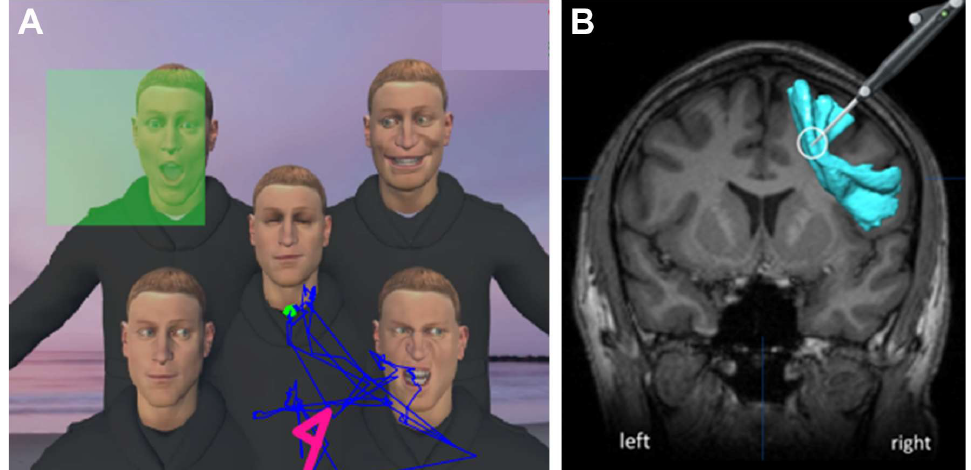
Figure 5. Resection of a malignant glioma in the frontal lobe. ( A ) VR-TANGO test during the DES. The patient was unable to detect the communicative cues, namely, eye contact (green square at the top left). His gaze remained fixed on the first face encountered. ( B ) Coronal neuronavigation showing the location of the DES electrode (white circle) in contact with the FAT (blue). (DES, direct electrical stimulation; FAT, frontal aslant